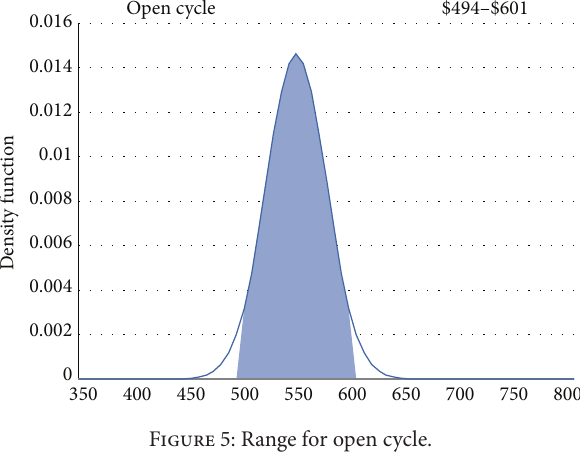
Figure 5: Range for open cycle.